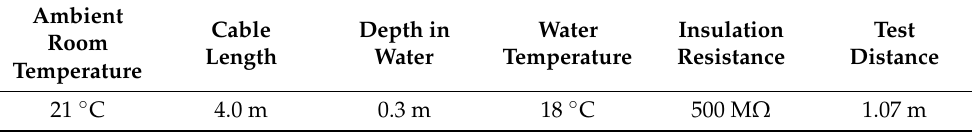
Table 3. Actual test environment of the